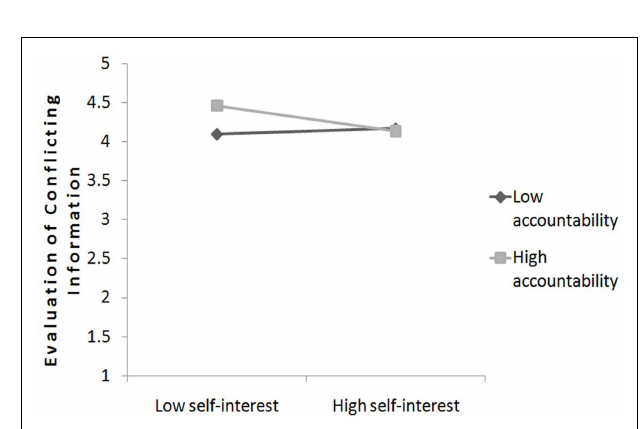
FIGURE 5 |The relationship between self-interest and evaluation of conflicting information as a function of advisor’s perceived accountability (study